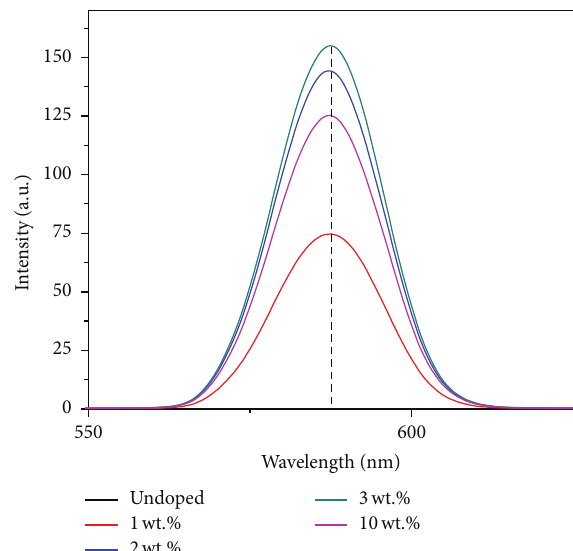
Figure 6: Emission spectra of undoped and Mn-doped Zn 2 SiO 4 based glass-ceramic sintered at 600 ∘ C ( 𝜆 excitation = 260 nm, = 585 nm). Lines are drawn to guide the eye. 𝜆 emission